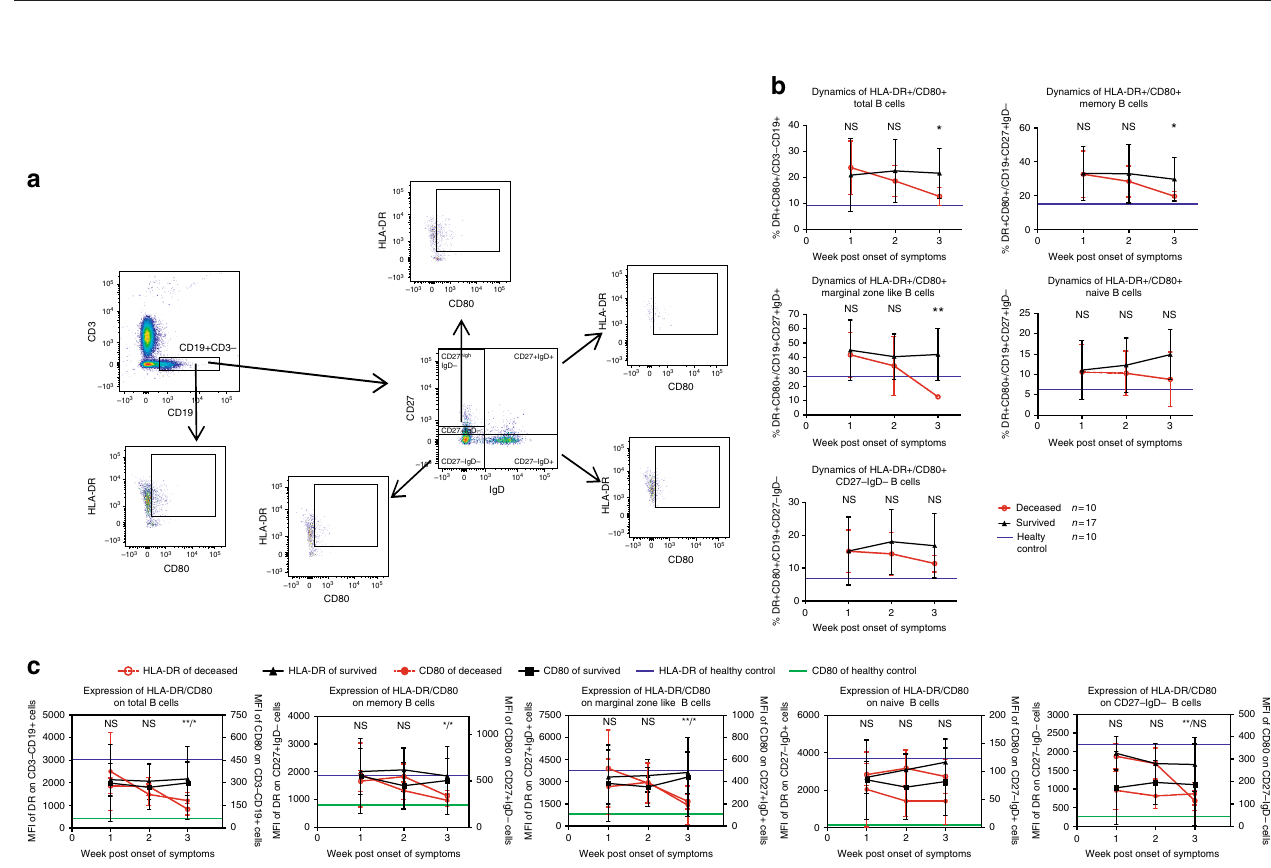
Fig. 7 Phenotypic analysis of antigen-presenting B-cell subsets during acute phase of SFTS. a FACS gating strategy for the measurement of the expression of HLA-DR and CD80 on B-cell subsets. b Kinetics of the proportion of HLA-DR + CD80 + B cells in various B-cell subsets in the 3-week period post symptom onset among survived and deceased patients and healthy individuals. Black triangles, red circles and blue horizontal lines represent means of survived, deceased and HC group, respectively. c Kinetics of the expression of HLA-DR and CD80 on B-cell subsets as measured by MFI. All symbols in the graph represent means of the expression of HLA-DR or CD80 of different groups. Statistic analysis was conducted between the survived and deceased group.* p < 0.05, ** p < 0.005, NS = no signi fi cance. Error bar represents the standard